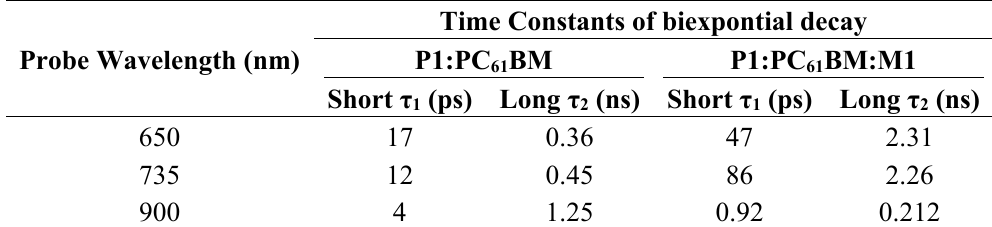
Figure 5. Transient absorption signal of ( a ) P1:PC 61 BM and ( b ) P1:PC 61 BM:M1 with a pump wavelength of 400 nm with energy of 0.7 μ J/pulse and a probe wavelengths of 735 nm (black circles) and 550 nm (red triangles). Red lines are biexponential fittings and the black lines at Δ T/T = 0 are shown as a guide to the eye. Table 4. Time decay constants for transient absorption (TA) signal for the different studied